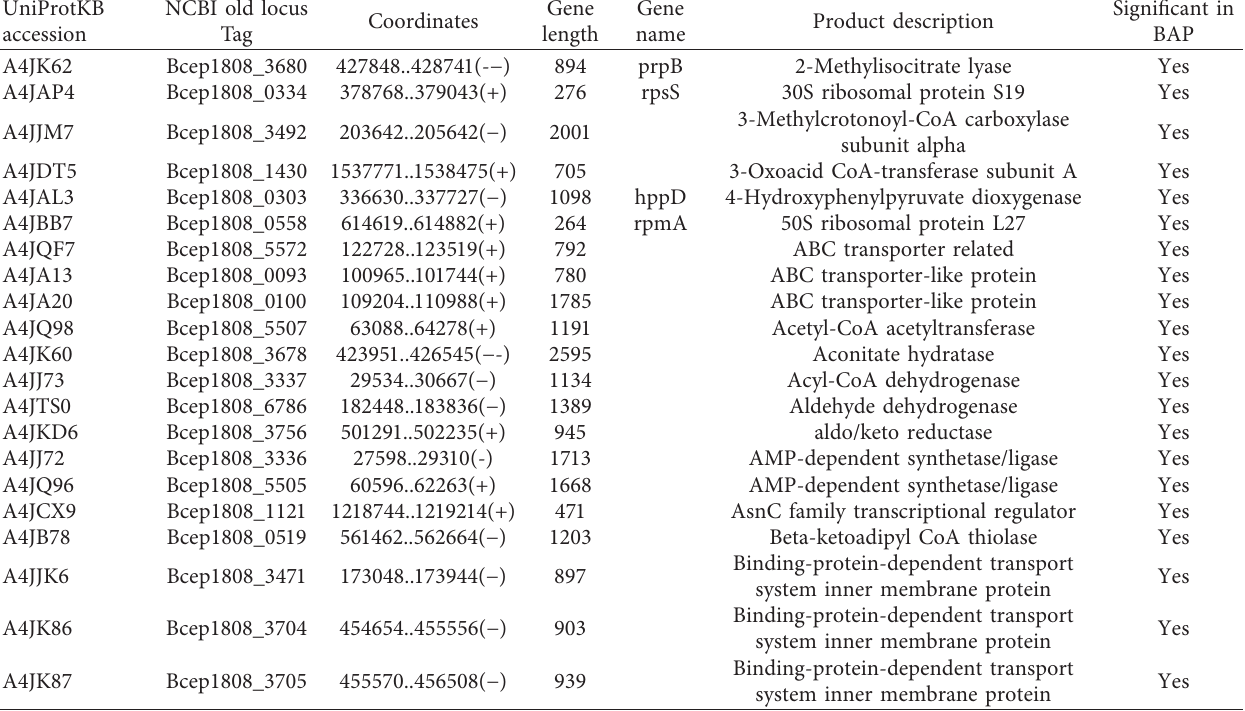
Table 1: Genes significantly expressed in the experimental group exposed to